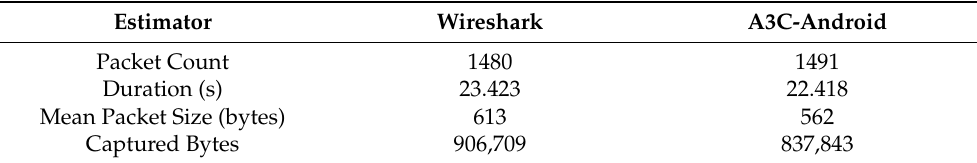
Table 5. Quantitative comparison of A3C-Android to Wireshark.